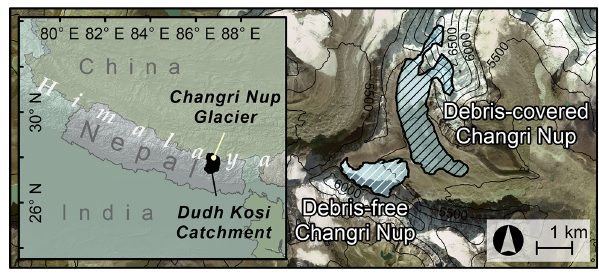
Figure 1. Study area overview showing the general location (in- set map) and delineation of debris-free and debris-covered Changri Nup glaciers. Background is from ESRI basemap